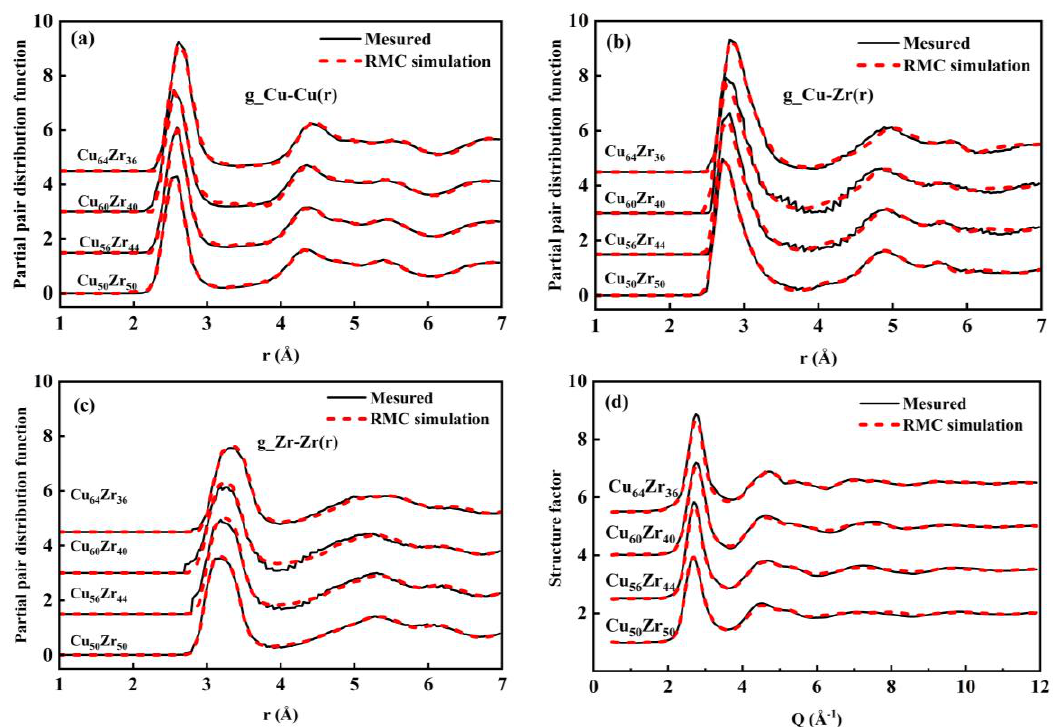
Figure 1. Comparison of partial PDFs from ab initio molecular dynamics (solid black line) with RMC (red dashed line) simulation data for ( a ) g_Cu-Cu(r), ( b ) g_Cu-Zr(r), ( c ) g_Zr-Zr(r), respectively. ( d ) denotes the comparison of S( Q ) from synchrotron XRD (solid black line) and RMC simulations (red dashed line). ( a – d ) demonstrate the four tested metallic glasses Cu X Zr 100 − X (x = 50, 56, 60, 64), respectively.